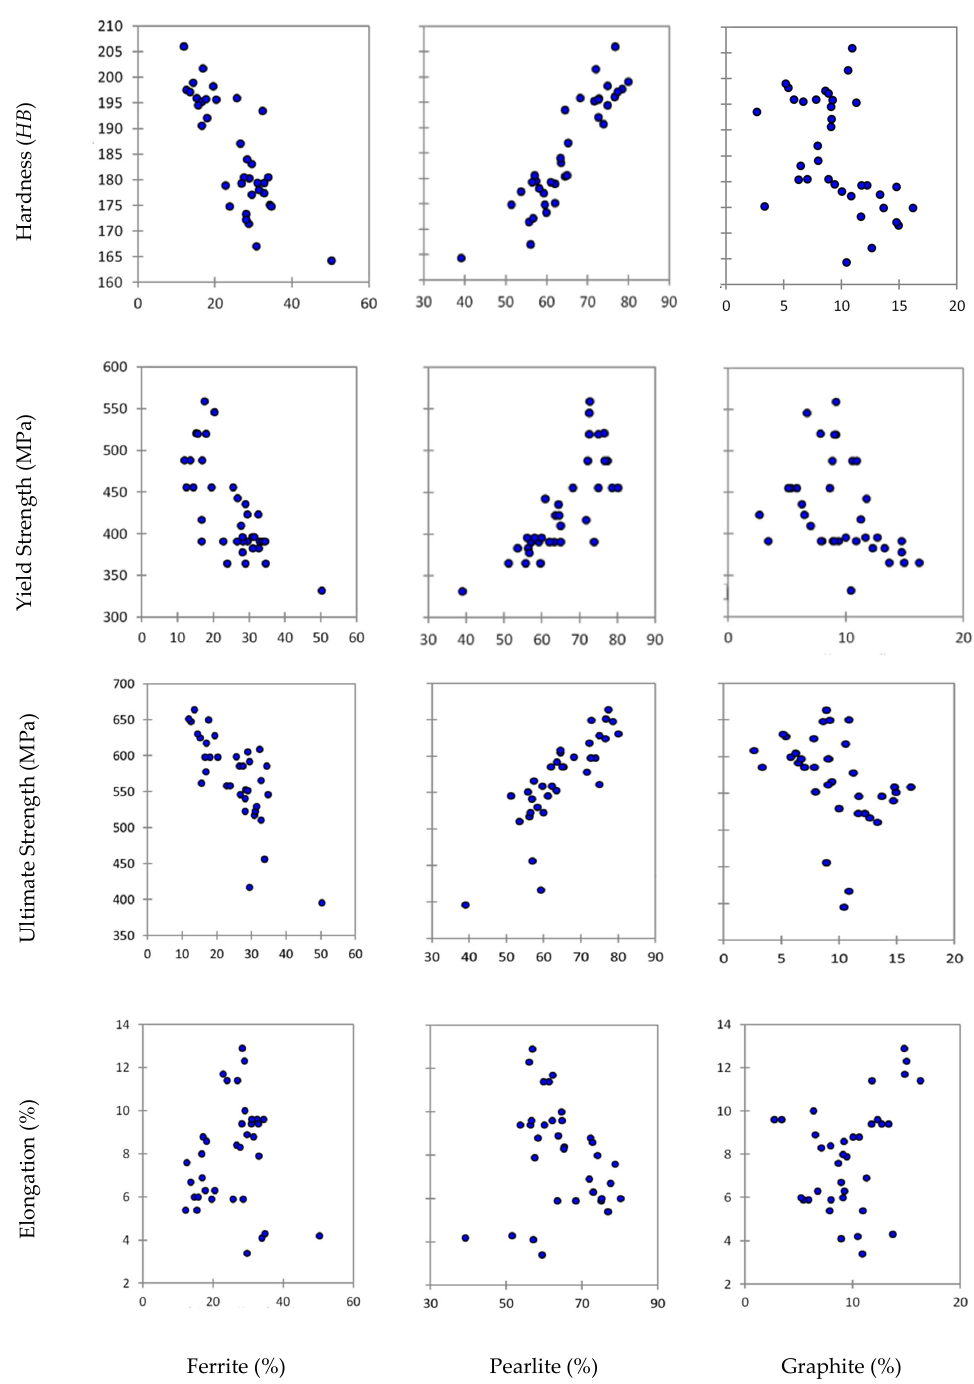
Figure 9. Microstructural information about the graphite nodules (such as the density, dimension and nodularity) in the case of: ( a ) a single specimen, ( b ) average values of specimens from the same cube side.